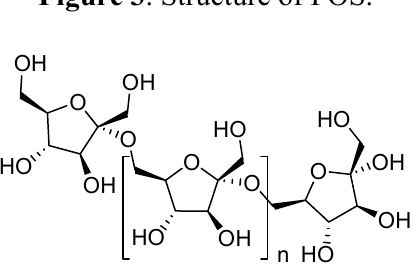
Figure 3 . Structure of FOS.